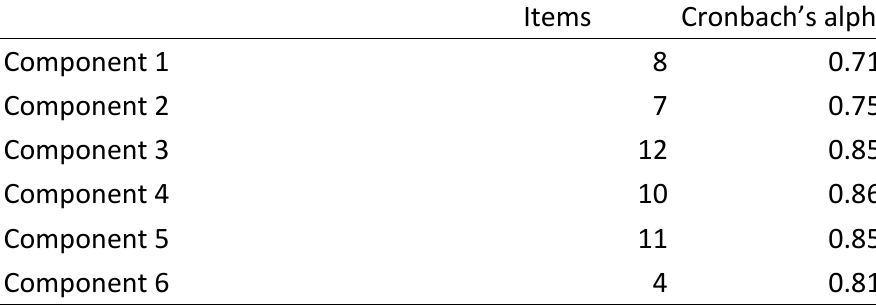
Table 4: Cronbach’s reliability factor